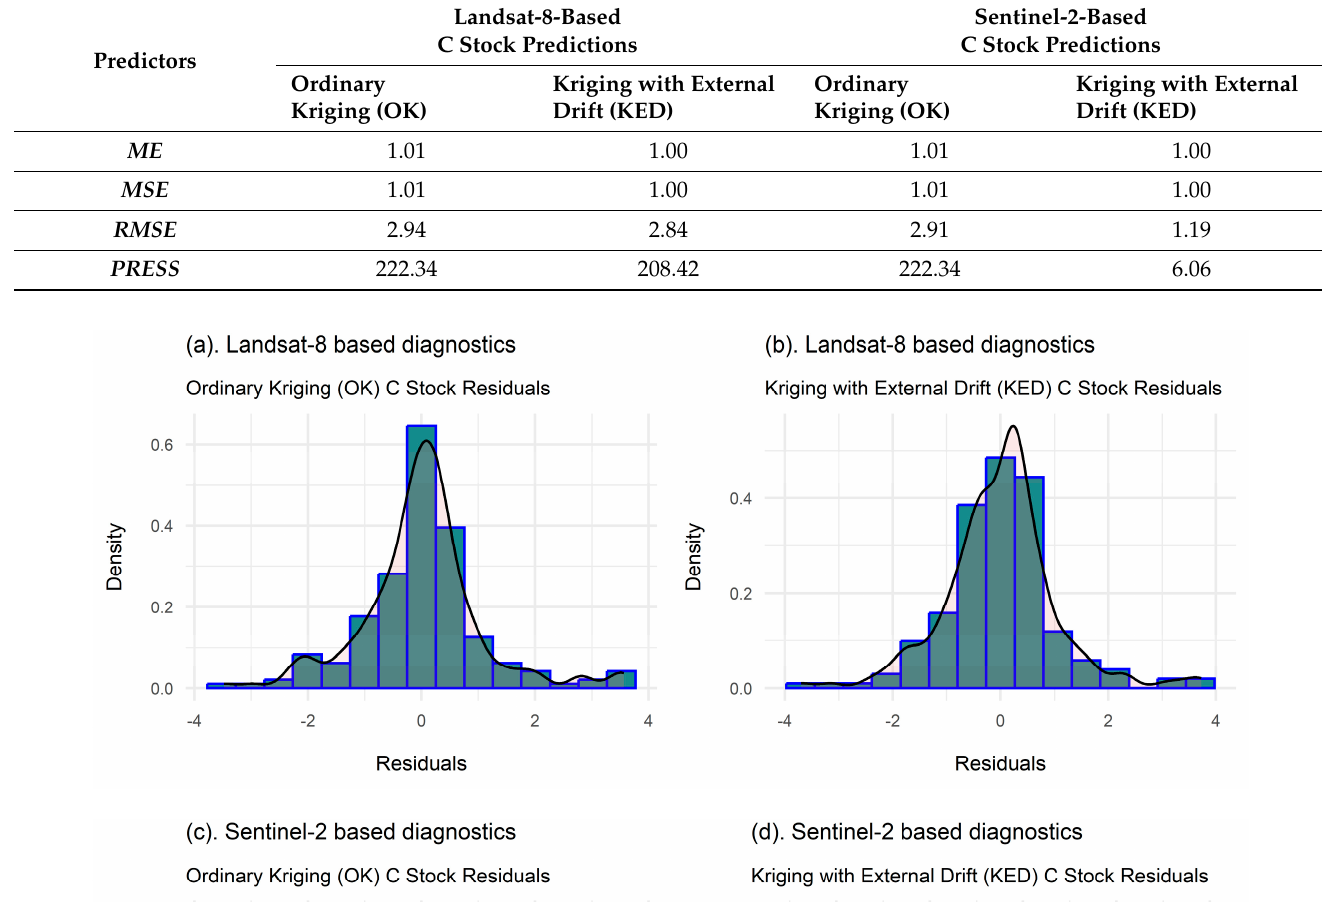
Table 5. Frequentist geostatistical C stock prediction validation statistics.